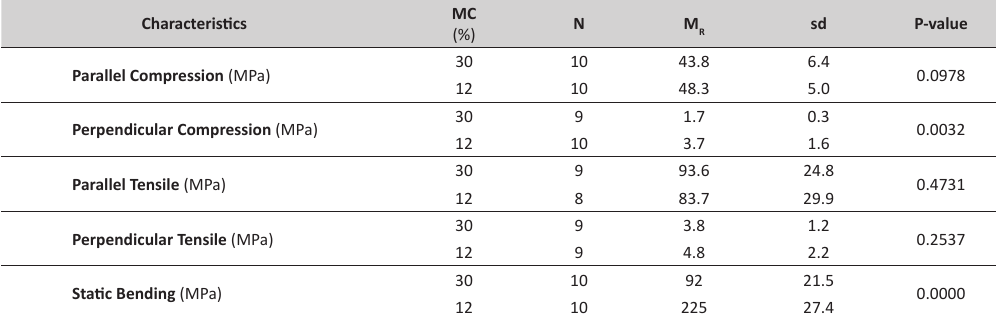
TAble 3. Eucalyptus maidenii wood modulus of rupture.